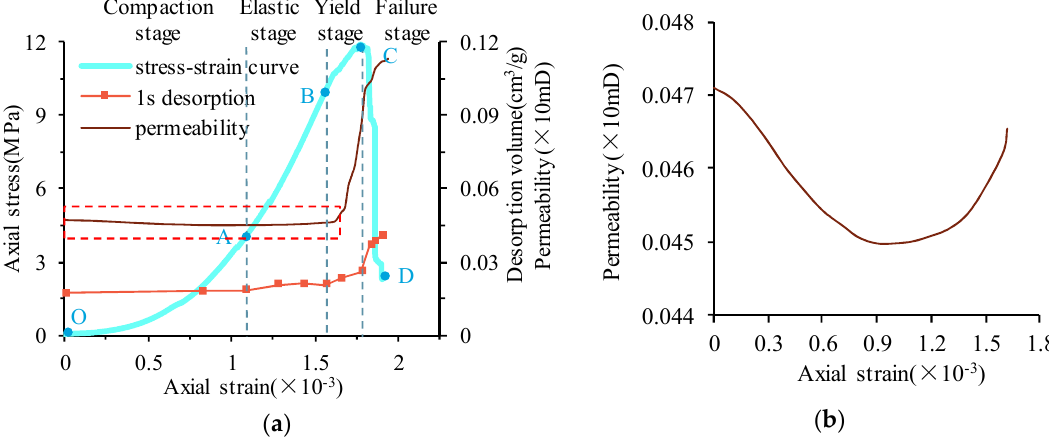
Figure 5. Released methane volume and permeability of the coal during stress loading. ( a ) Released methane volume and permeability of the coal in the four stages; ( b ) permeability of the coal in the compaction and elasticity stages.